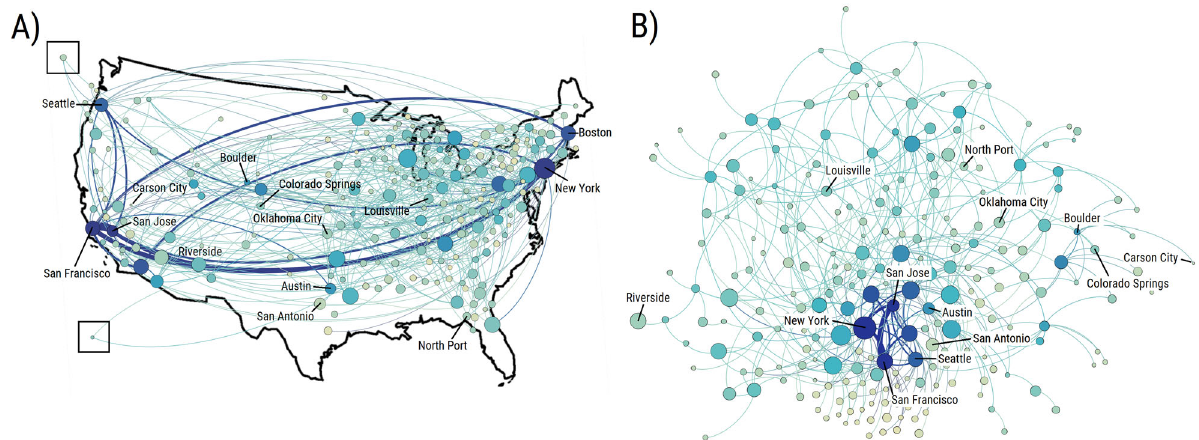
Fig. 4 The backbone of the Workforce Mobility Network (WMN) visualized. A On the map of the United States; and B on a standard force-directed network layout. A node ’ s size is proportional to the area ’ s population size, its color intensity is proportional to its PageRank centrality, and an edge ’ s width is proportional to its